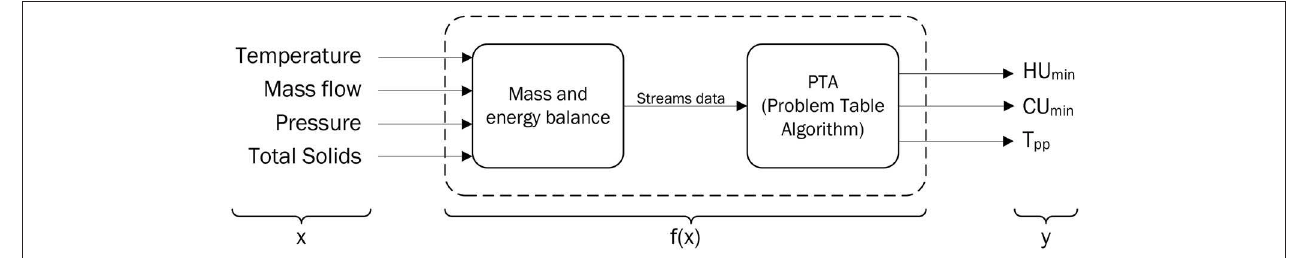
FIGURE 3 | Conceptual model